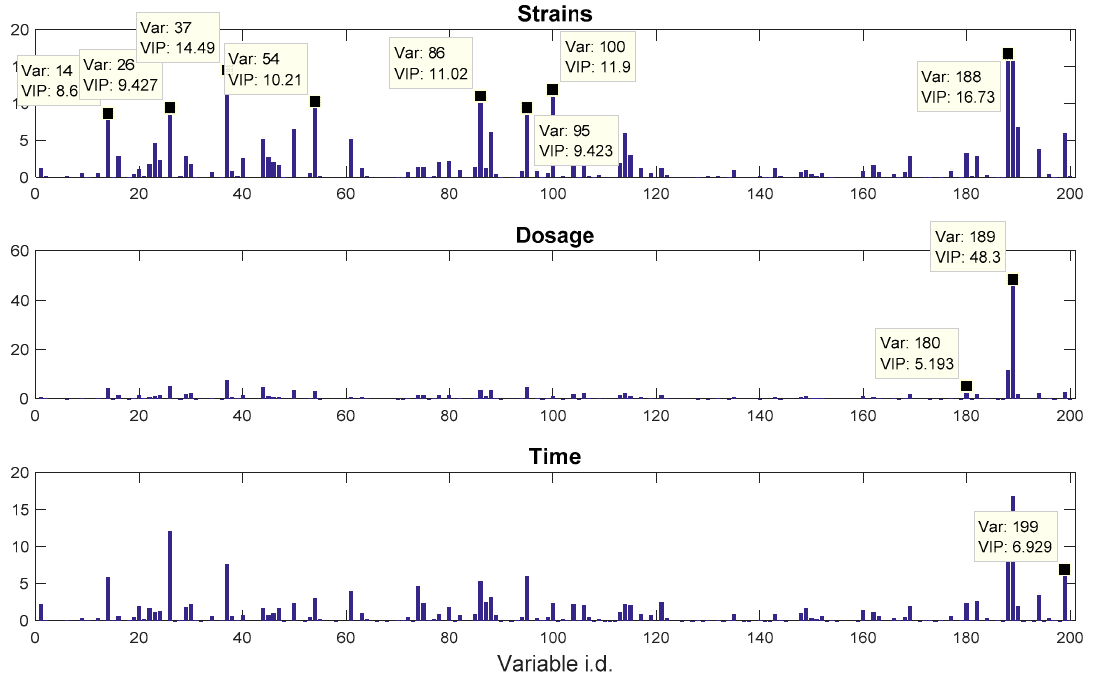
Figure 4. VIP score plots for the propranolol data. The variable identification and their corresponding VIP score values were annotated in the data tips.